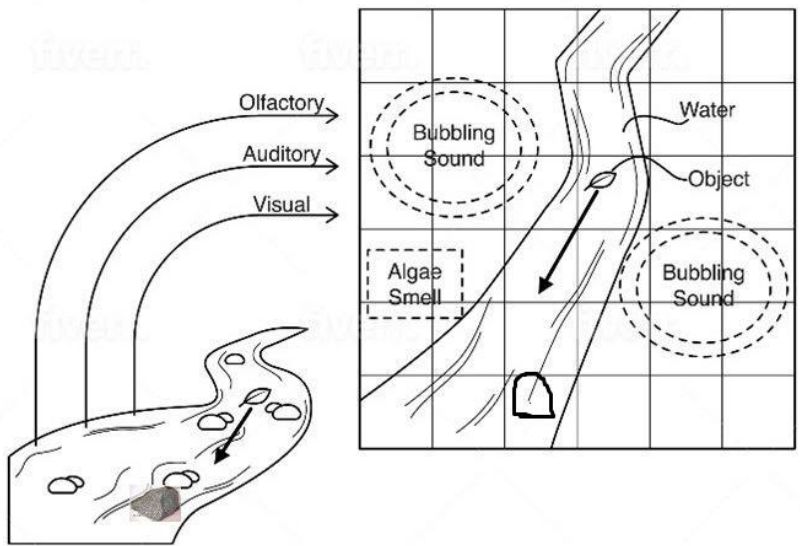
Figure 3. Different features from different sensory modalities of the sensory scene are here bound to WNM (working navigation map), which represents a river. Note a moving object on the river. A motion prediction vector represents the movement of the object. The larger rock in the river is represented in the navigation map as well. The updated navigation map is now termed the working navigation map WNM’ .